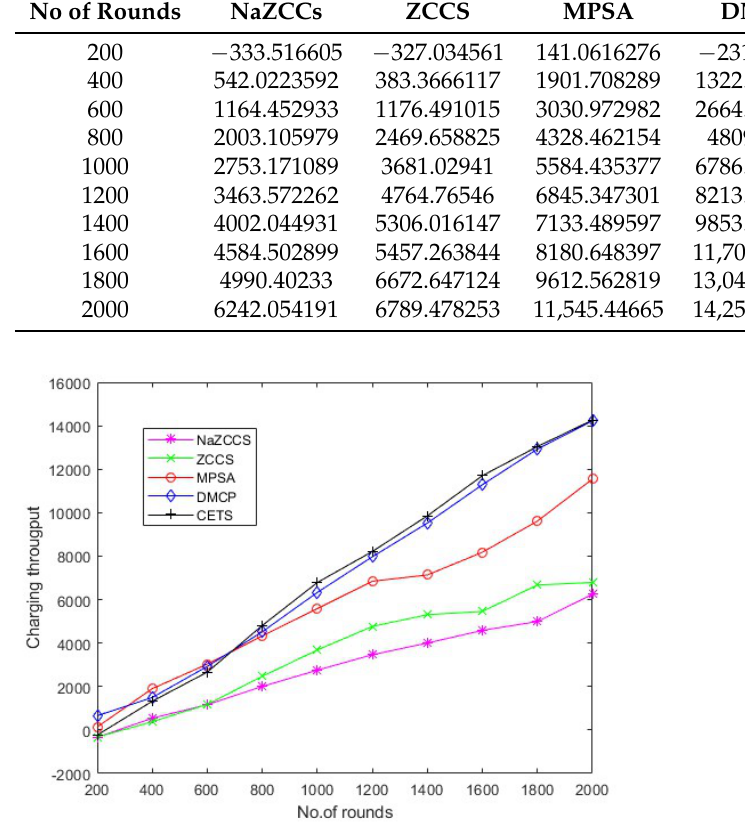
Figure 14. CETS versus other models on charging throughput per round at hop density 0.3.